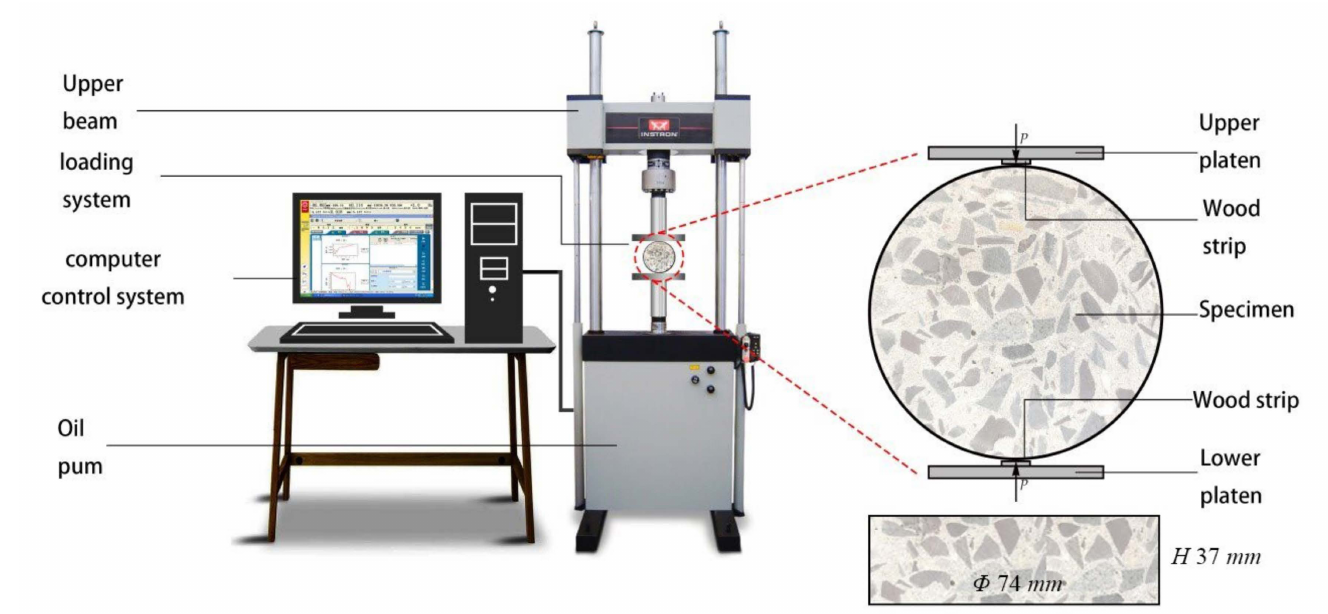
Figure 1. Schematic diagram of Brazilian disc splitting tensile